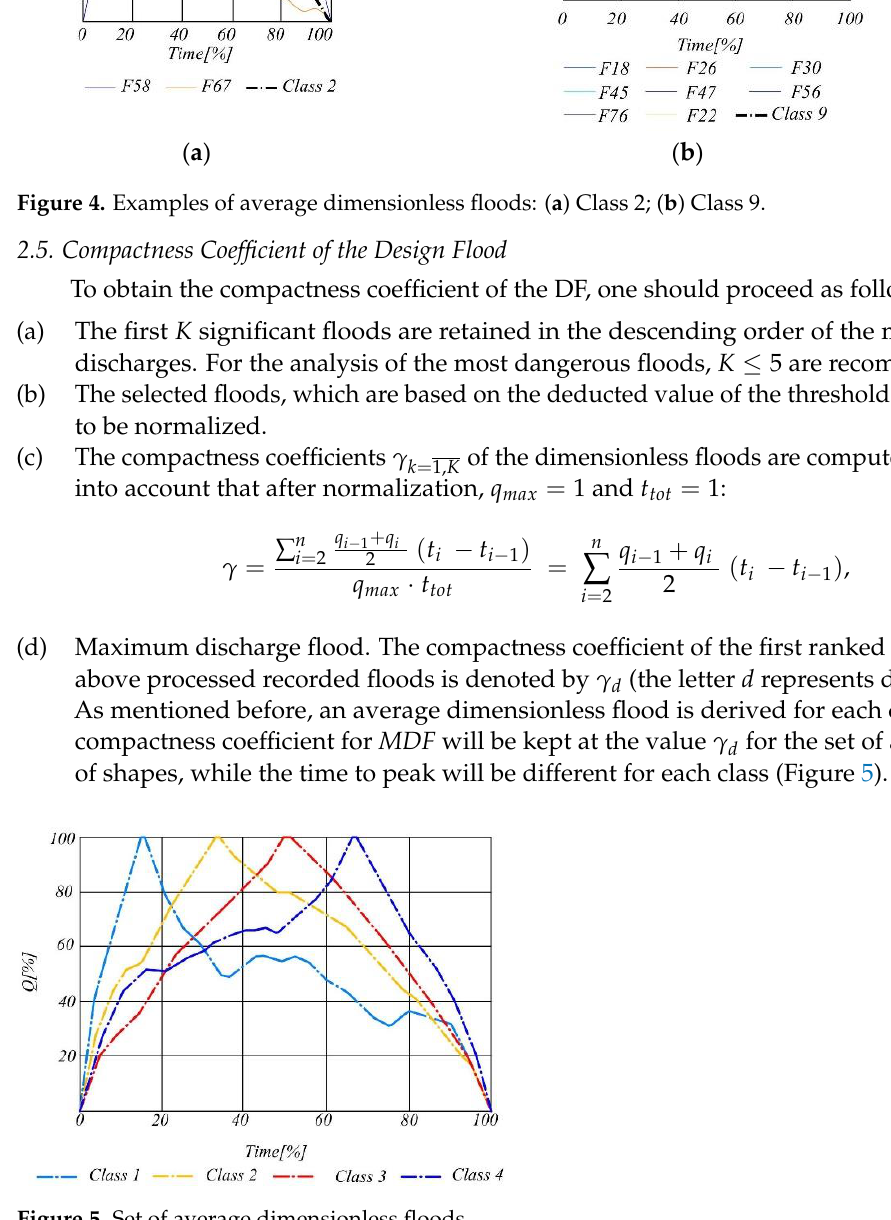
Figure 5. Set of average dimensionless